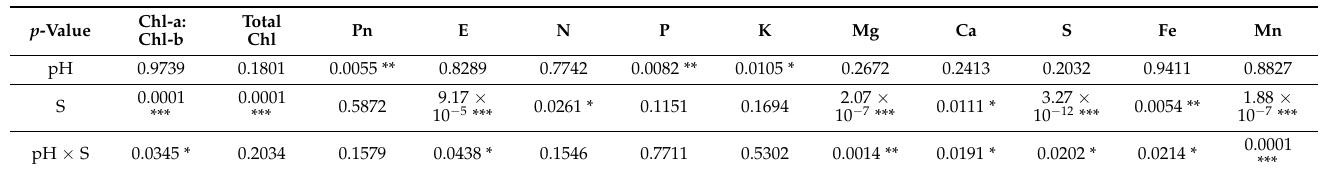
Table 2. ANOVA table showing p -values effects of pH and S treatments on the parameters measured in beaked hazelnut ( n =